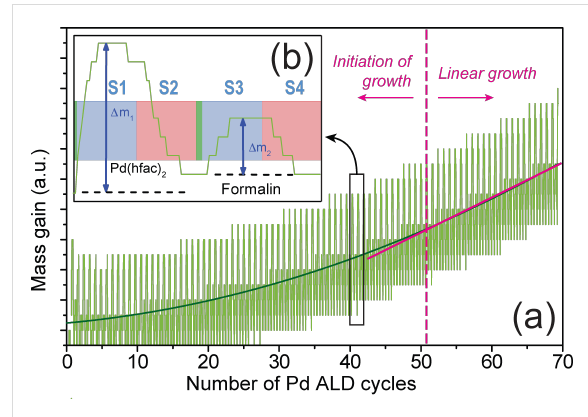
Figure 8: In situ QCM measurements of Pd mass gain during the ALD process for Pd. (a) General evolution and (b) enlarged view of one ALD